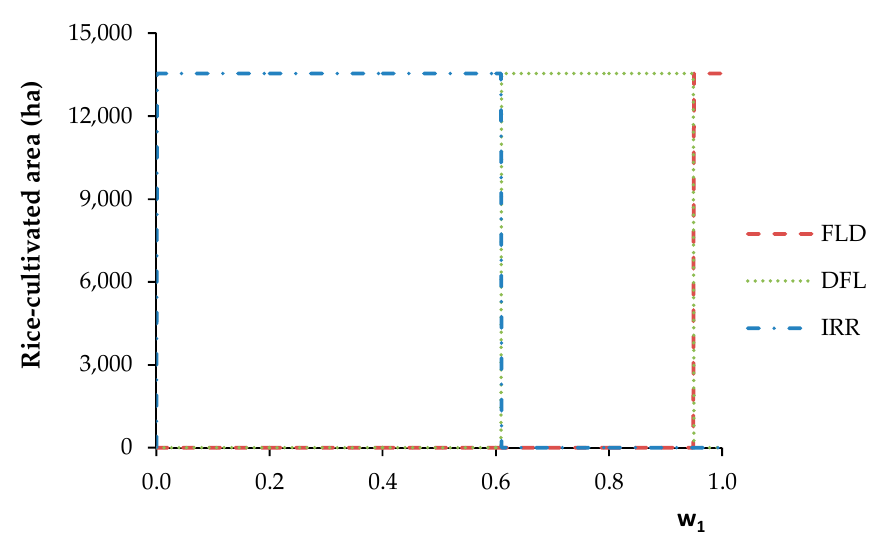
Figure 5. Water saved and gross margin with different sets of weights. Still ensuring the same amount of water saved, the introduction of more productive cultivars increases the regional gross margin. Such a possibility is however limited to dry and semi ‐ dry cultivations. Introducing the innovative cultivars specifically selected would enhance economic results especially because of a higher yield, rather than different production costs. From this perspective, gross margins undergo an augmentation by 16% in the DFL condition, whilst by only